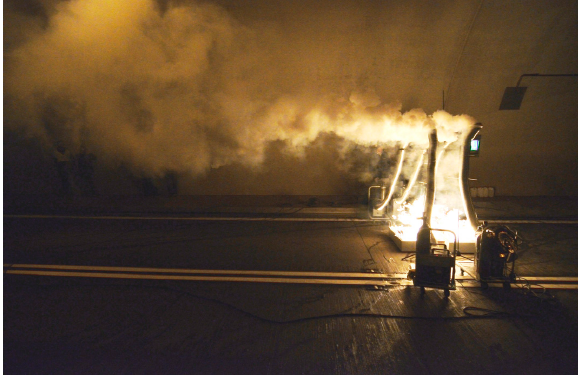
Figure 5. Horizontal direction of smoke flow during the first hot smoke test.